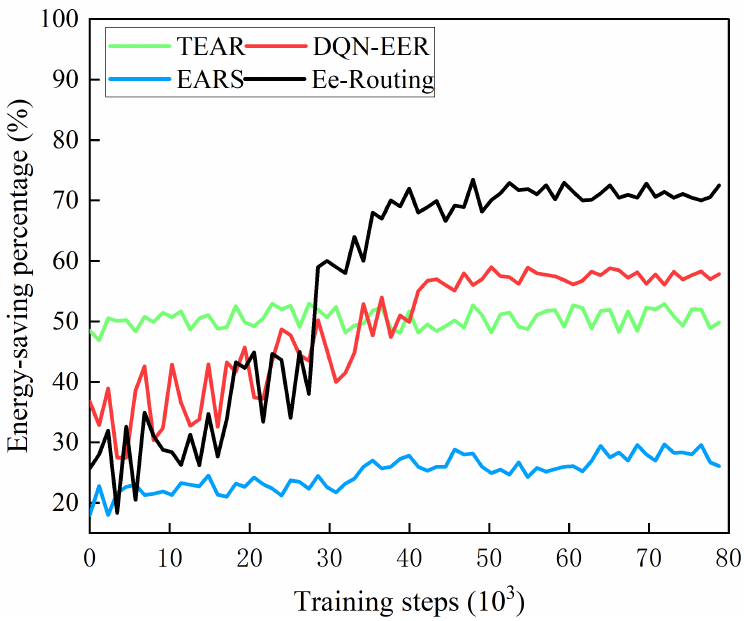
Figure 8. Energy-saving percentage under 80% traffic